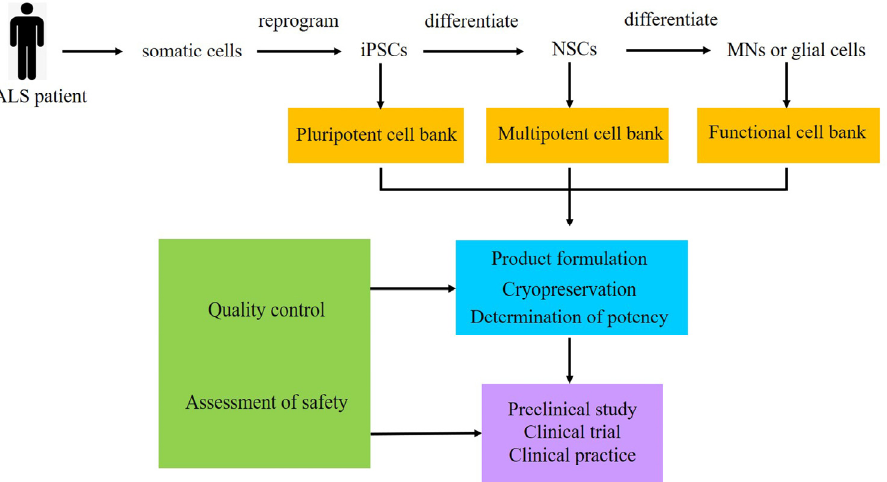
Figure 3. Ideas for cell therapy of ALS with iPSCs. iPSCs: induced pluripotent stem cells, NSCs: neural stem cells, MNs: motor neurons.